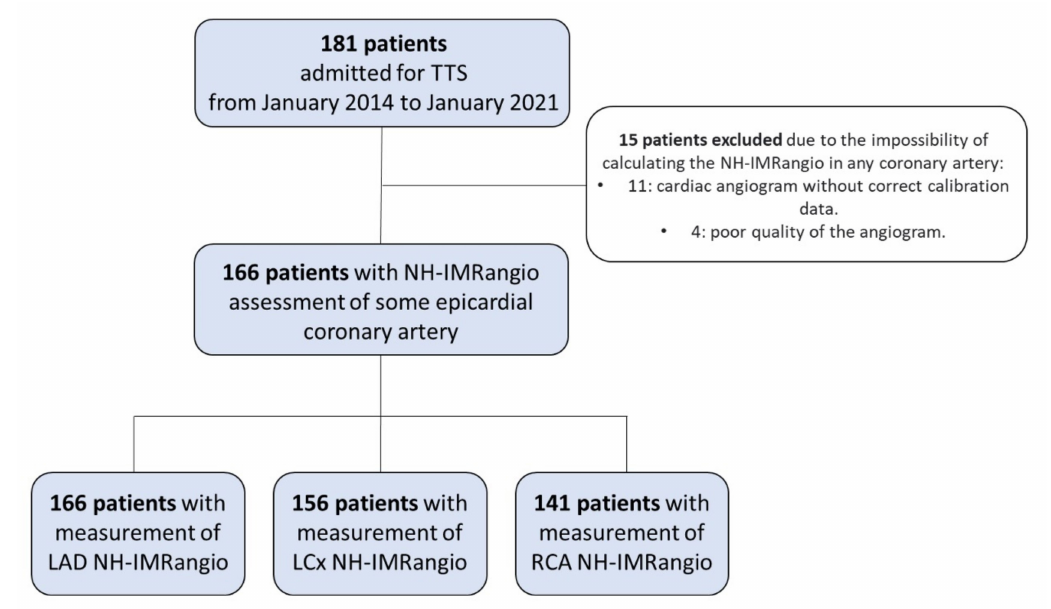
Figure 1. Patients flow chart. TTS: Takotsubo syndrome; NH-IMRangio: non-hyperaemic angiography-derived index of microcirculatory resistance; LAD: left anterior descending; LCx: left circumflex artery; RCA: right coronary artery.